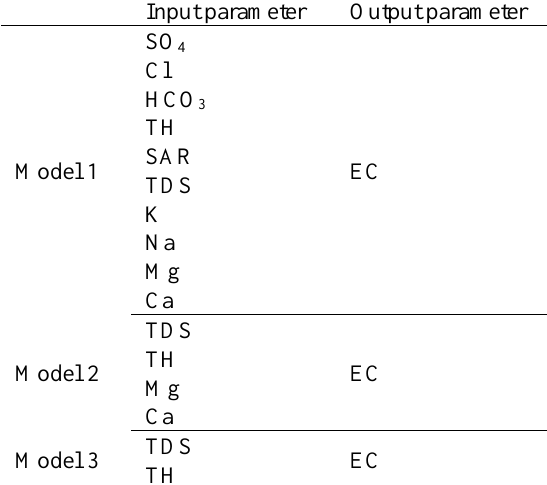
Table 2. Neural network structure